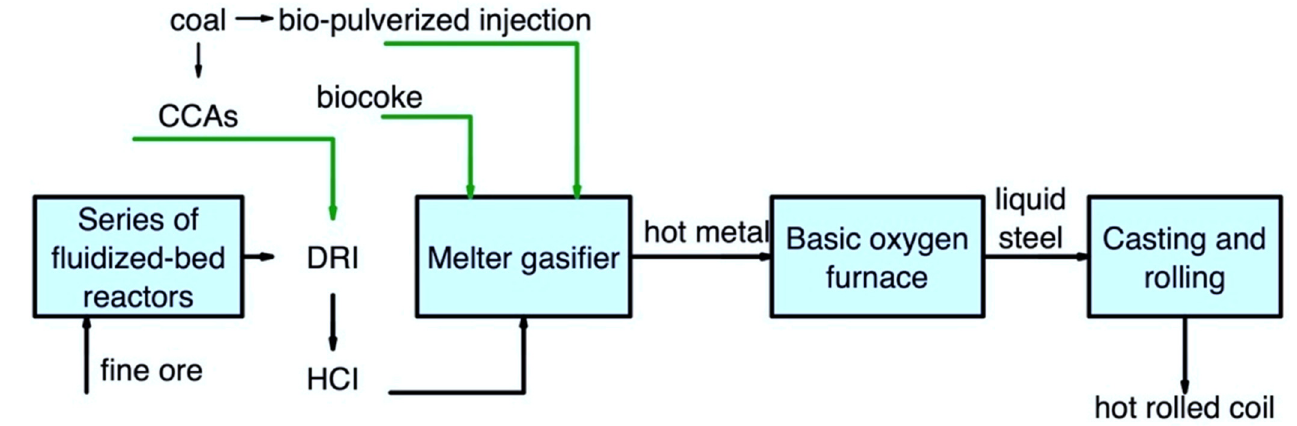
Figure 8. Main pathways for using secondary carbon bio-carriers in the FINEX/BOF route.